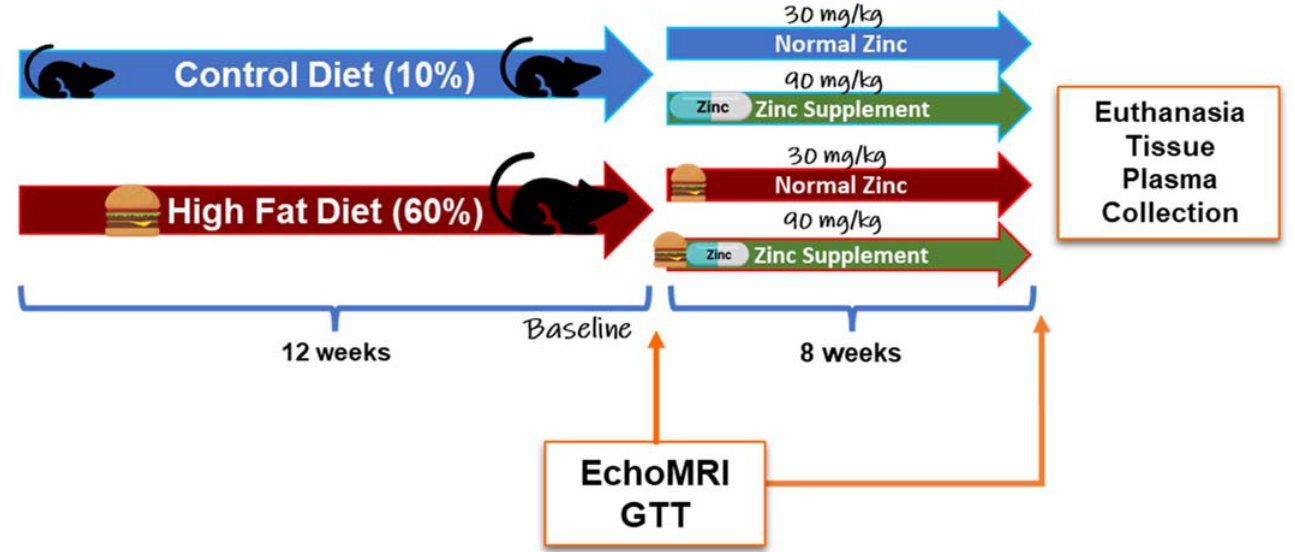
Figure 1. Exposure paradigm. 9-week-old male C57BL/6J mice were fed control (n = 30, 10% fat-kcal) or HFD (n = 30, 60% fat-kcal) for 12 weeks, after which they were further subdivided into normal zinc (n = 15, 30 mg zinc/4057 kcal) or zinc supplemented (n = 15, 90 mg zinc/4057 kcal) diet groups for an additional 8 weeks. Prior to zinc supplementation and animal sacrifice, IPGTTs were conducted, and body composition determined by Echo MRI. IPGTT = intraperitoneal glucose tolerance